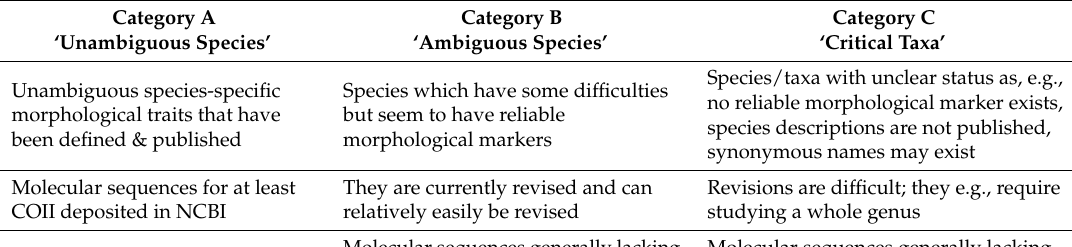
Table 1. Taxonomic status categories (category A, B, C).